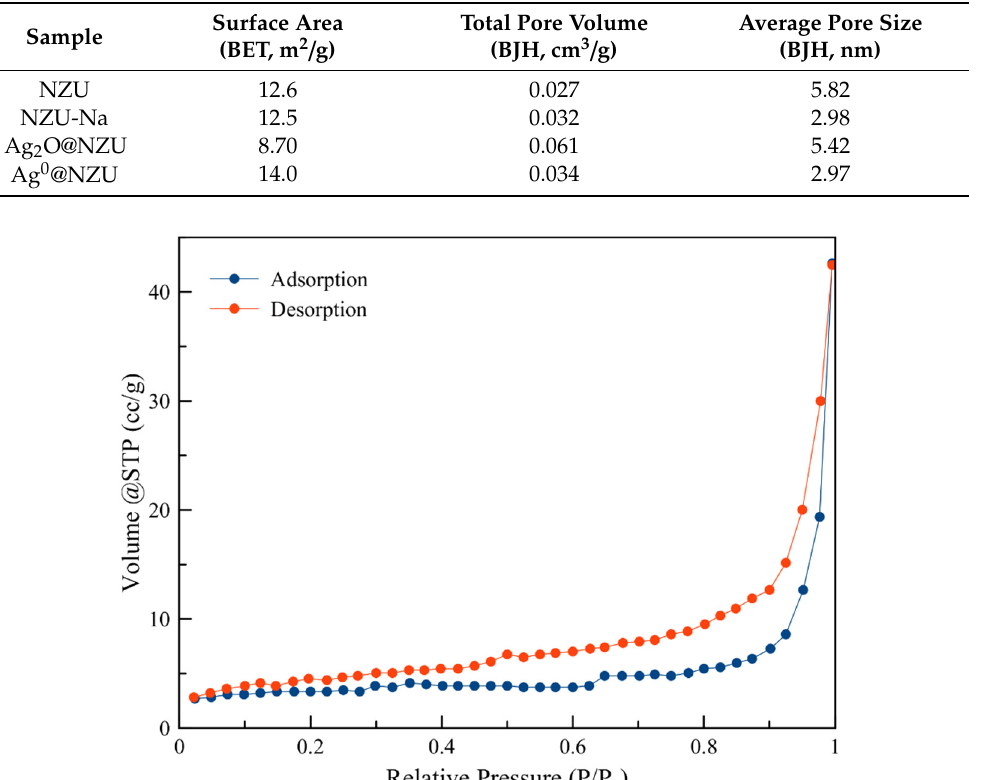
Figure 2. Adsorption-desorption isotherm for NZU.